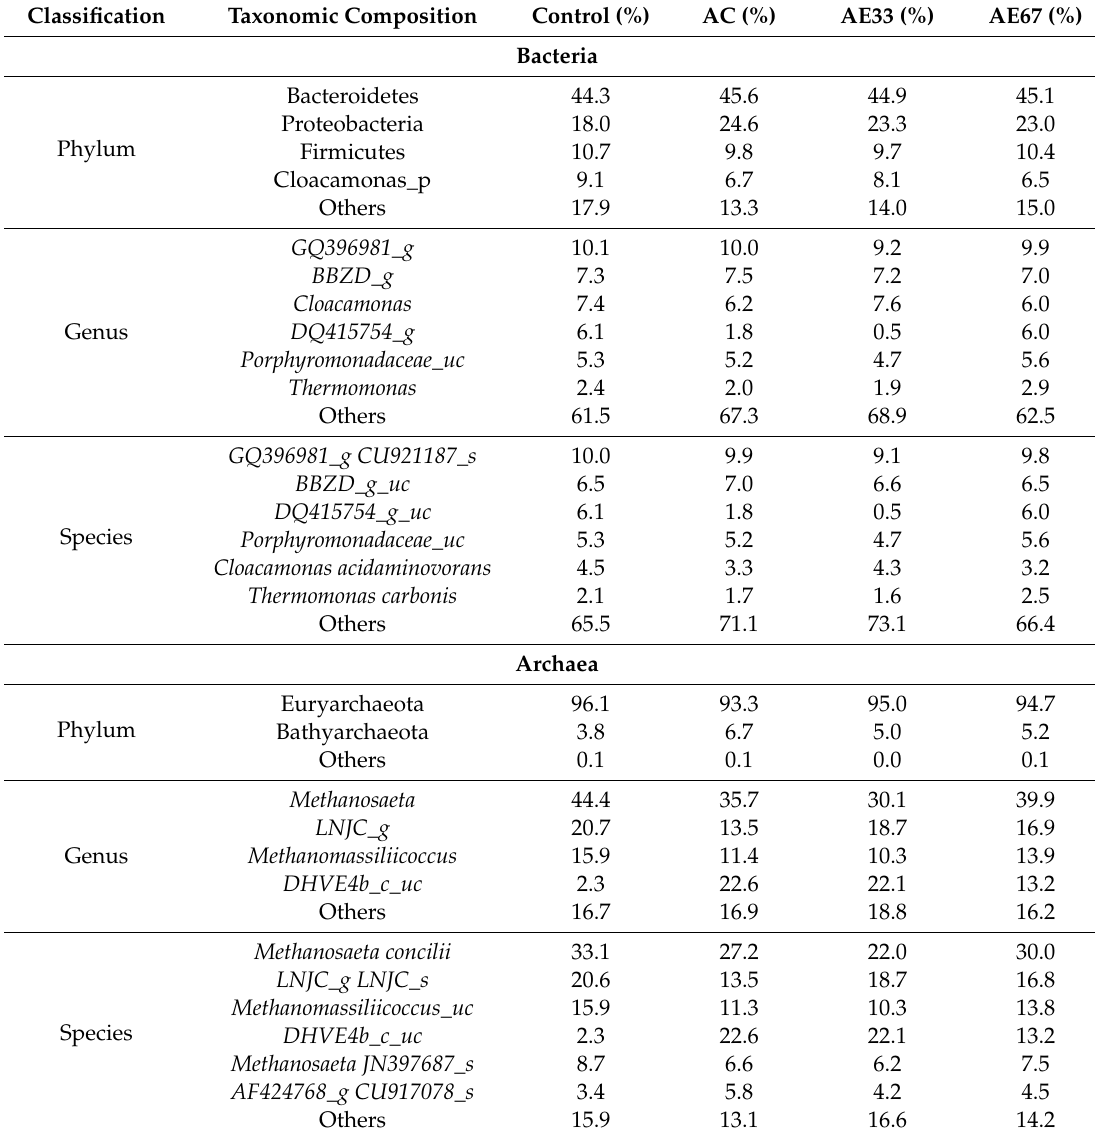
Table 5. Microbial phyla, genera, and species in the anaerobic reactors used for methane conversion of coal.